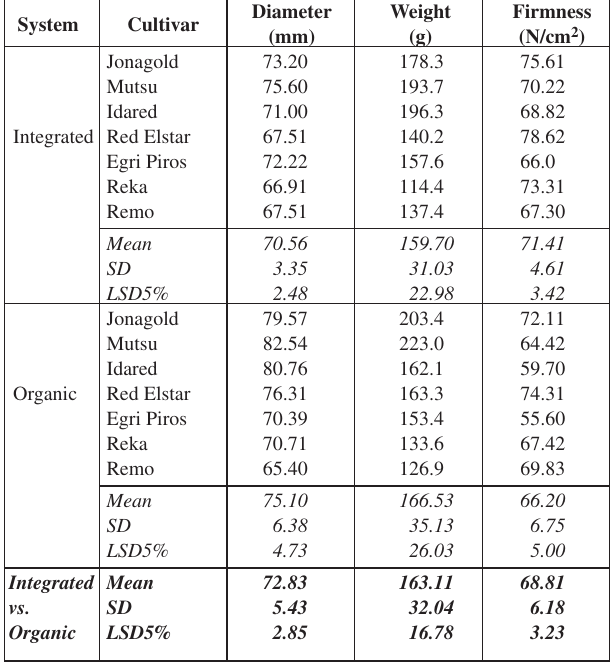
Table 1. Fruit qualifying parameters I. (means of three-year) Diameter System Cultivar